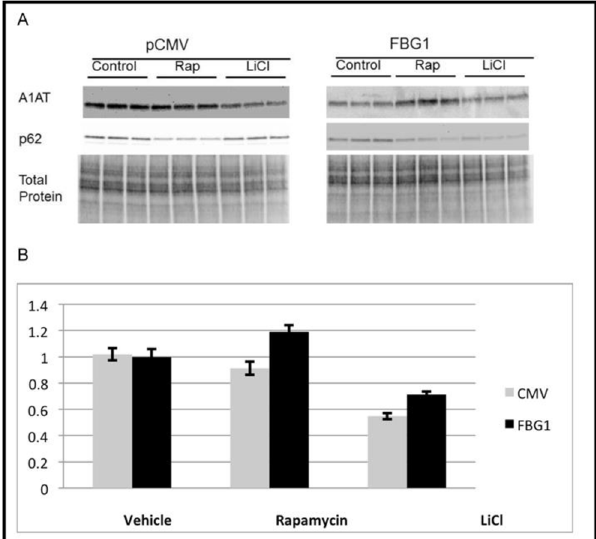
Fig 10. Stimulation of autophagy with lithium reduces A1AT-Z levels independent of FBG1. A1AT-Z was transfected with FBG1 or pCMV in Hepa1-6 cells, and 34 hours later the cells were either left untreated (Control) or treated with Rapamycin (Rap) or Lithium (LiCl) for 48 hours, then harvested, lysed, and separated on SDS-PAGE. Triplicate experiments are shown. A) Representative blot with bottom panel stained for total protein demonstrates equal amounts of protein were loaded in all the lanes. Upper panel shows decreased A1AT-Z after lithium-induced stimulation of autophagy but not rapamycin-induced autophagy. FBG1 does not further decrease A1AT-Z in the presence of lithium. B) ImageJ analysis showing mean values (n = 9) normalized to total